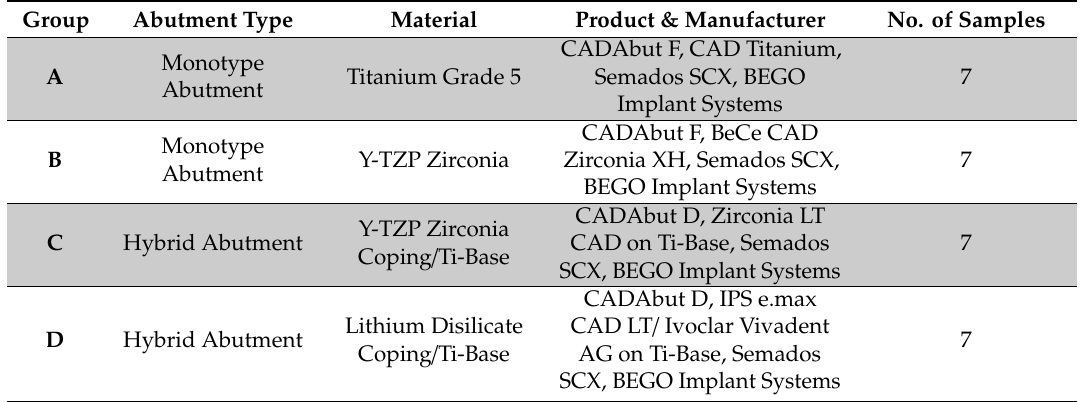
Table 1. Type, material, manufacturer, and sample size of tested CAD / CAM